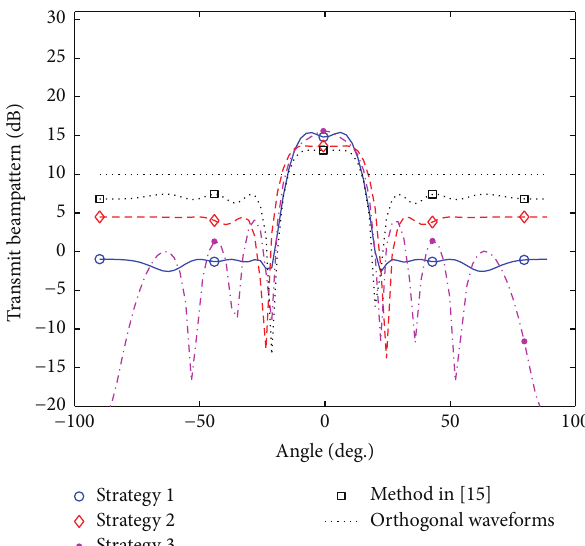
Figure 1: Transmit beampatterns of the orthogonal waveforms, method in [15], and the proposed strategies in Example